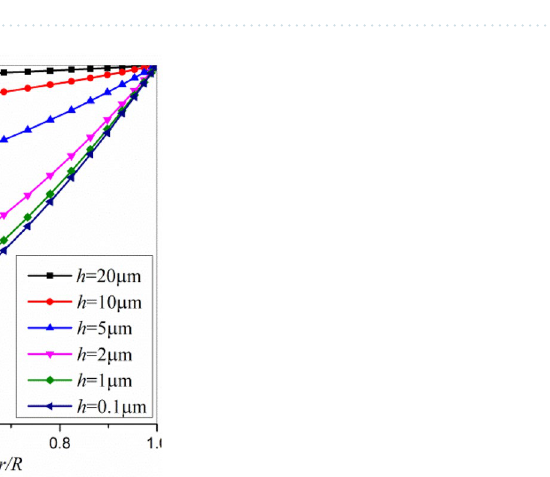
Figure 3. The dimensionless nonlinear displacements under different loads ( a ) the bending deflection, ( b ) the corresponding radial displacement.